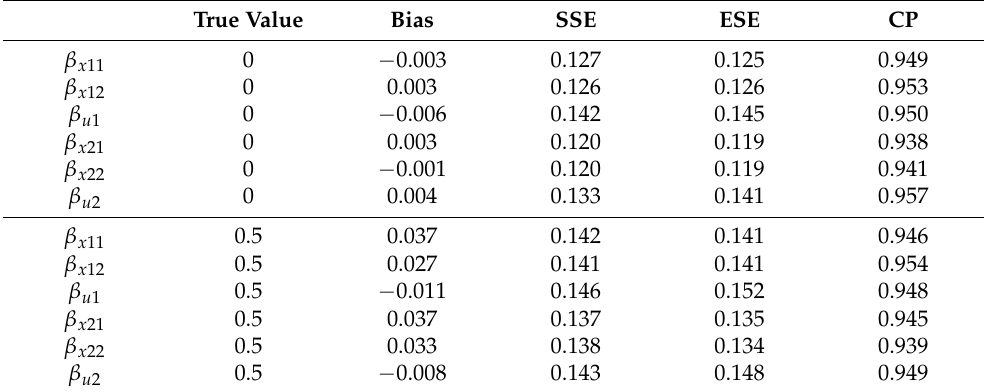
Table 3. Simulation results on estimation of β with the covariates generated from the normal distribution and r 1 = r 2 =